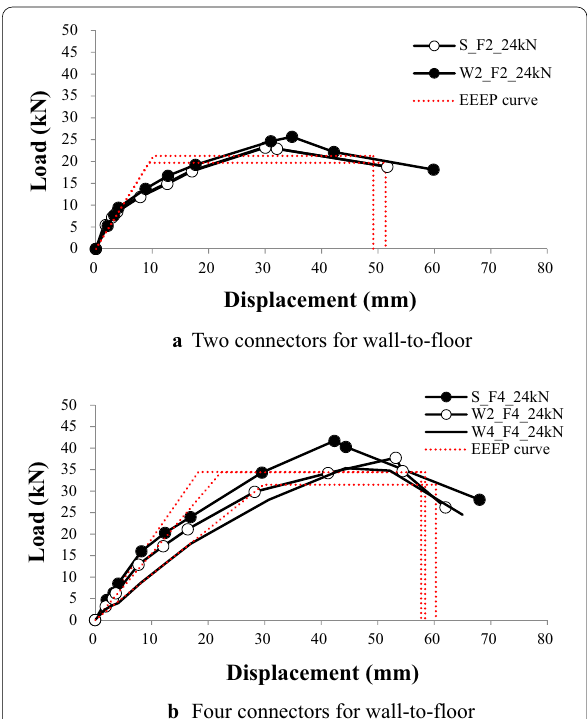
Fig. 10 Load–displacement curves depending on the number of wall‑to‑wall connectors